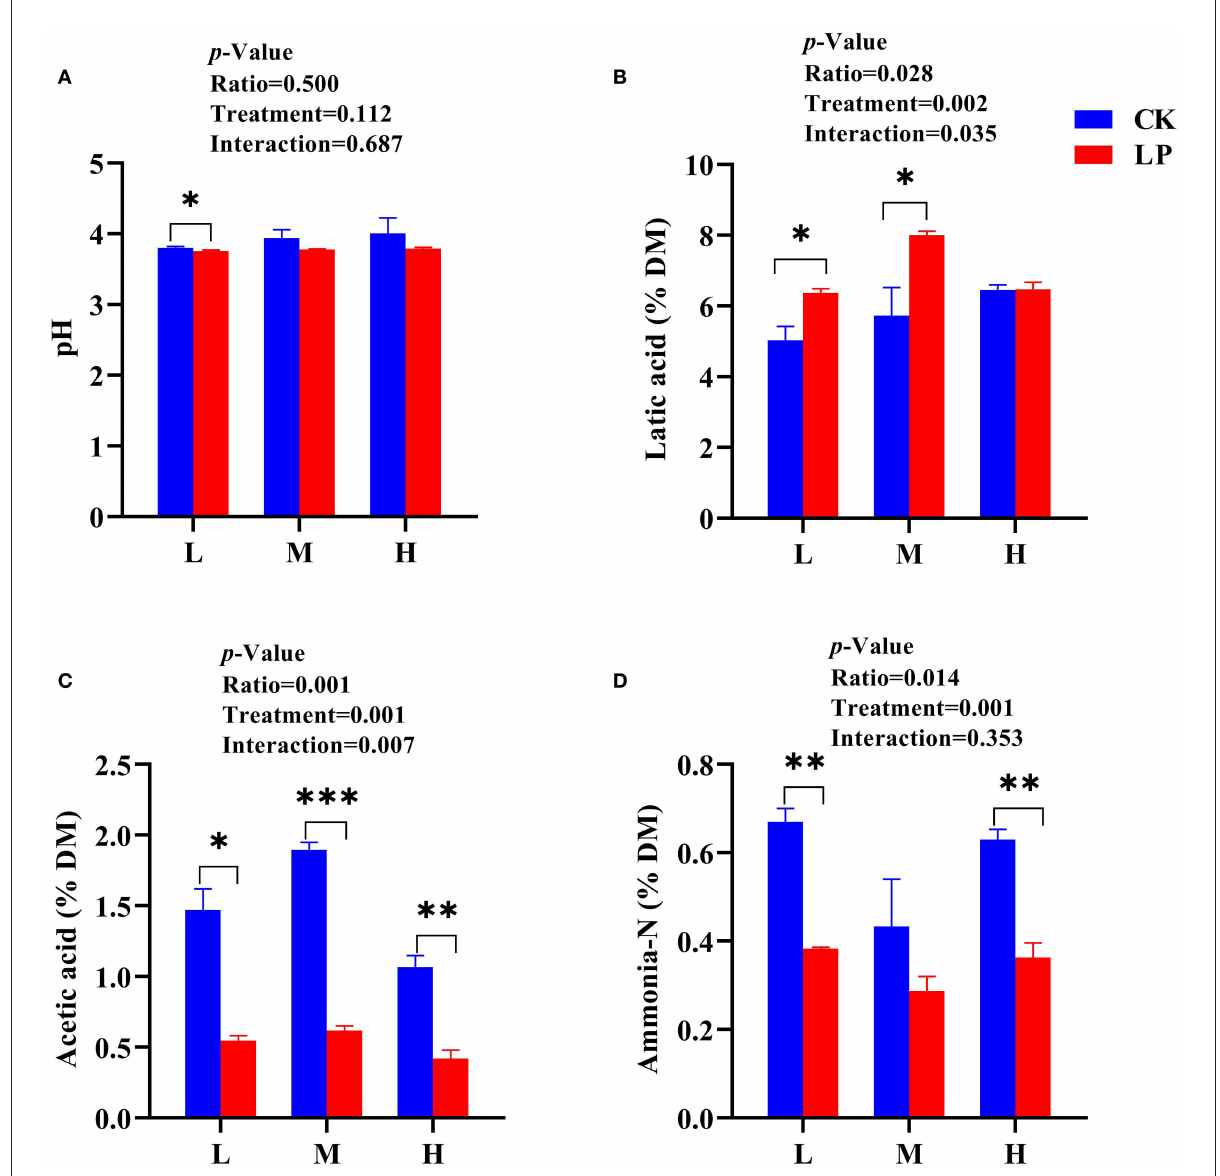
FIGURE1 Fermentation profile of Lablab and sweet sorghum intercropped silages with or without LP after fermentation. (A) for pH, (B) for lactic acid, (C) for acetic acid, and (D) for ammonia-N. CK, sterile water; LP, Lactobacillus plantarum ; L, Lablab and sweet sorghum seed-sowing ratio of 1:1; M, Lablab and sweet sorghum seed-sowing ratio of 5:1; and H, Lablab and sweet sorghum seed-sowing ratio of 9:1. “*,” “**,” and “***” represent the significance at 0.05, 0.01, and 0.001, respectively.